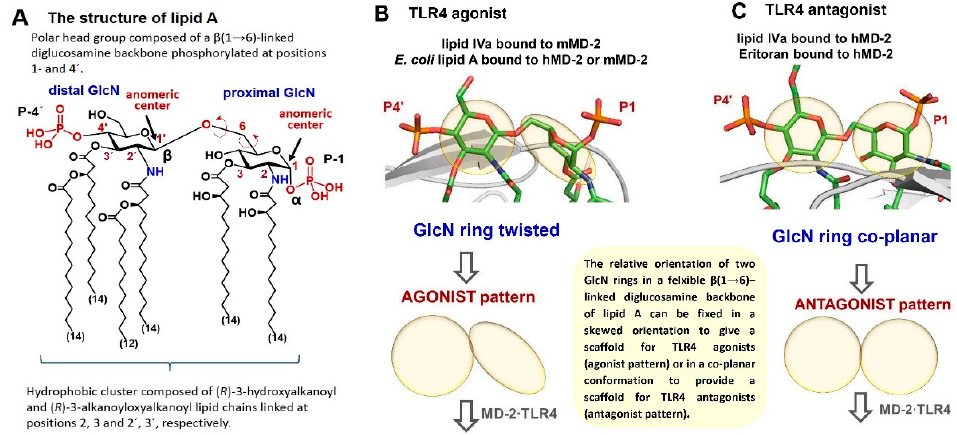
Figure 5. The chemical structure of E. coli lipid A and the 3D-tertiary structure of MD-2-bound lipid A in relation to biological activity. ( A ) Chemical structure of E. coli lipid A; ( B ) tertiary structure of the diglucosamine backbone of TLR4 agonist lipid A variants bound to MD-2/TLR4 complex; ( C ) tertiary structure of the diglucosamine backbone of TLR4 antagonist lipid A variants bound to MD-2; crystal-structure-based design of synthetic TLR4 ligands.